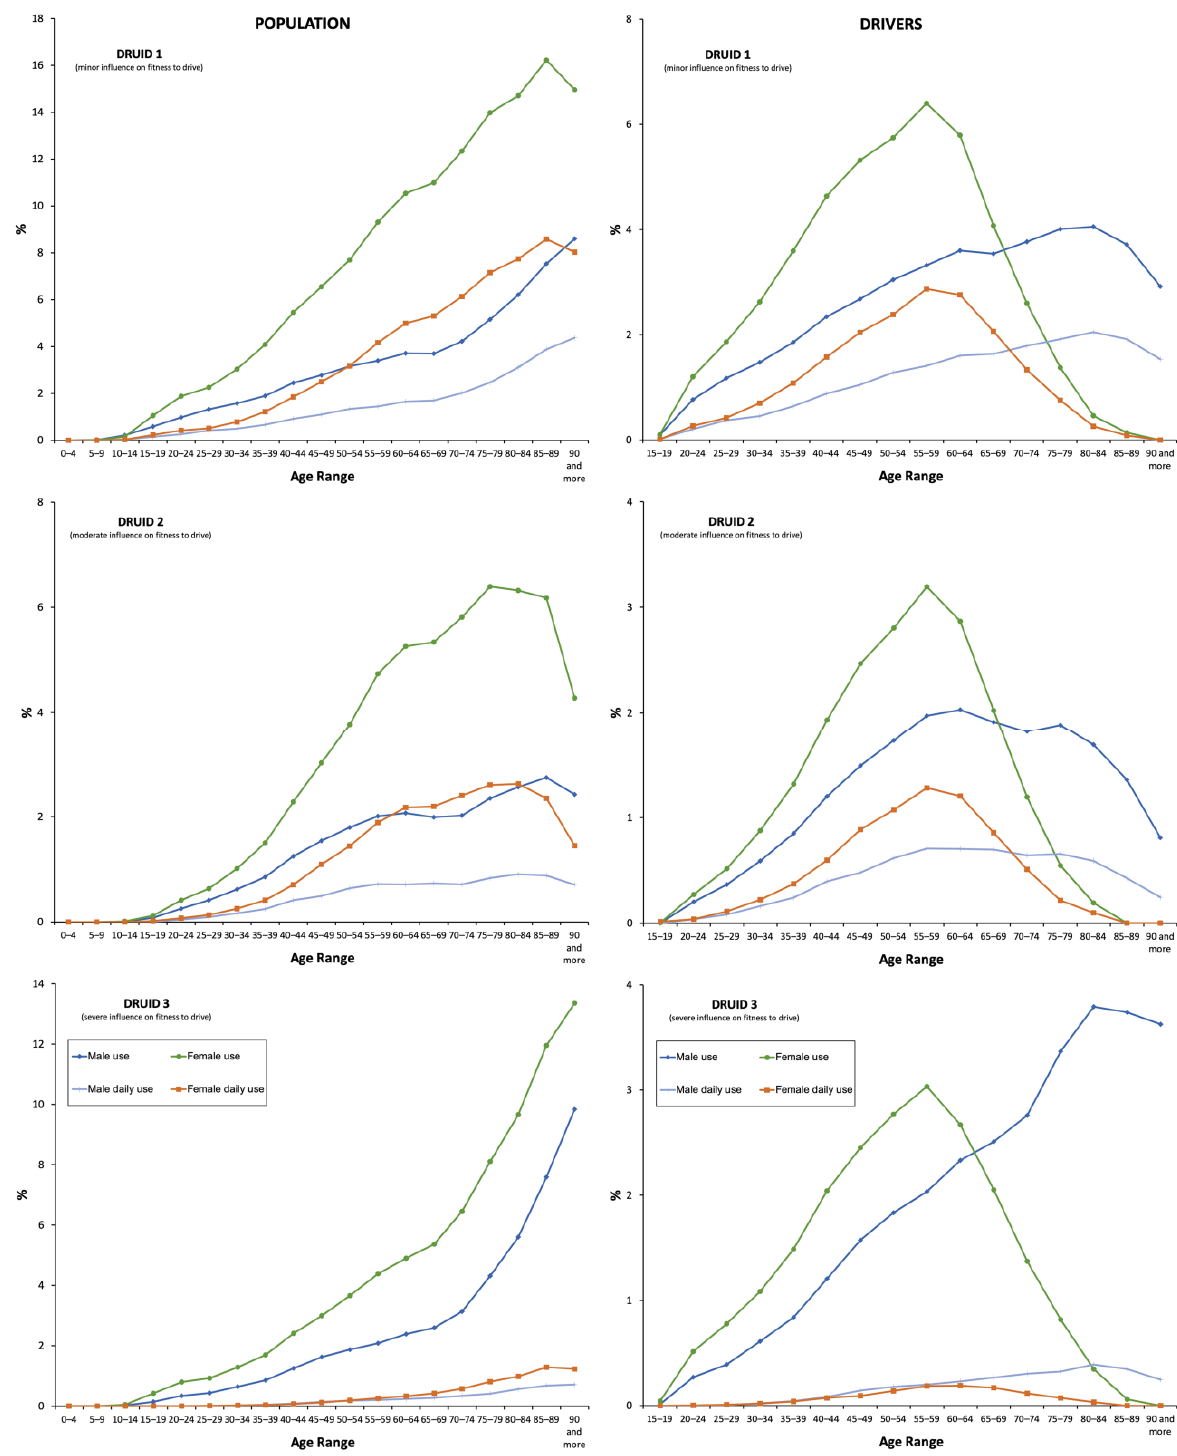
Figure 4. Frequency of use by Driving Under the Influence of Drugs, alcohol, and medicines (DRUID)